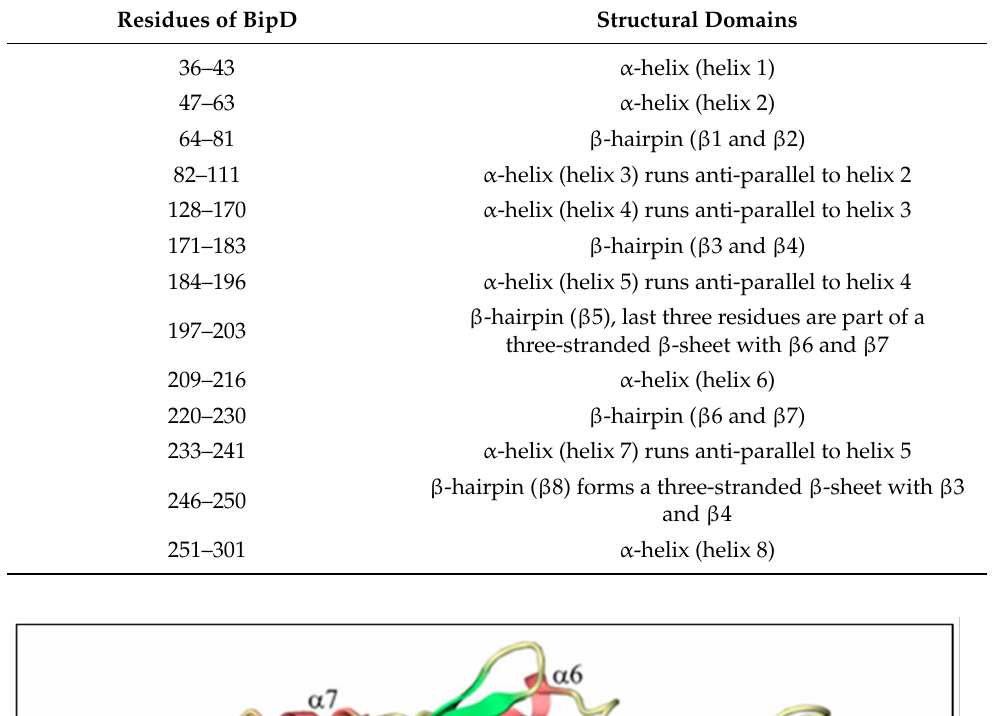
Table 1. Residues of Burkholderia invasion protein D (BipD) that represent structural domains. Adapted from [44].